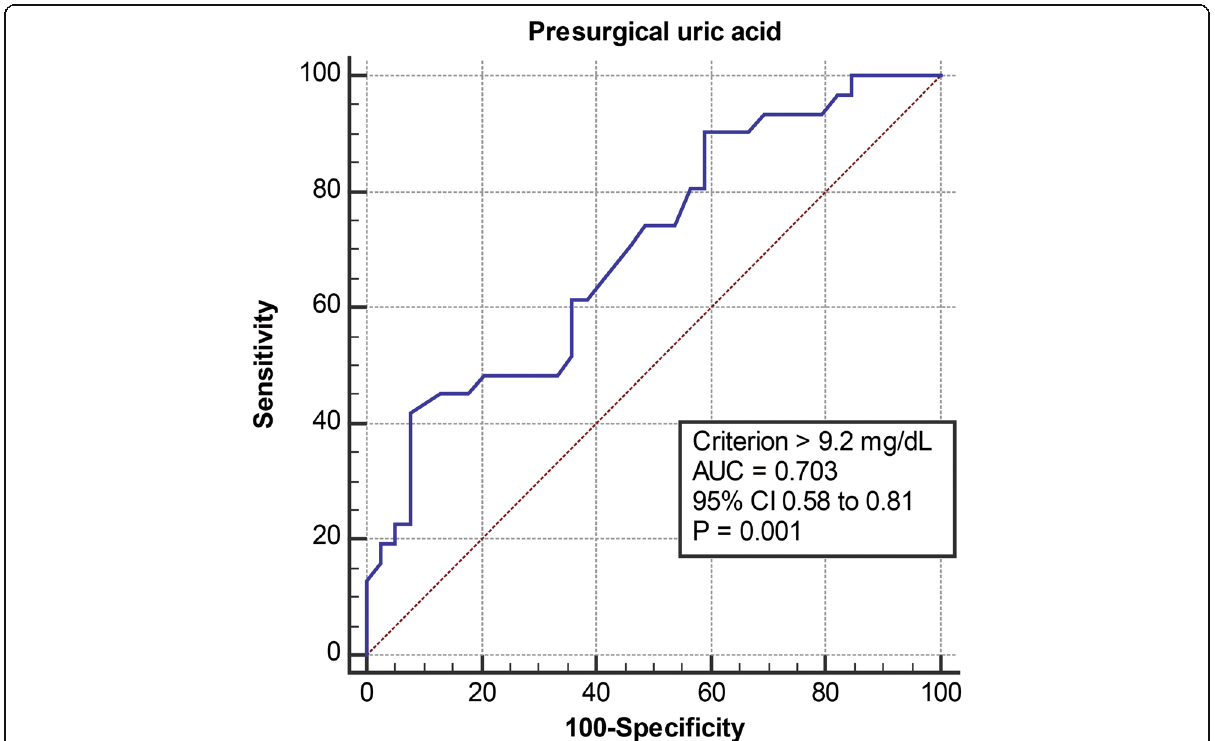
Fig. 1 Presurgical uric acid receiver operating characteristic (ROC) curve for prediction of postsurgical gout flare. CI, confidence interval; AUC, area under the